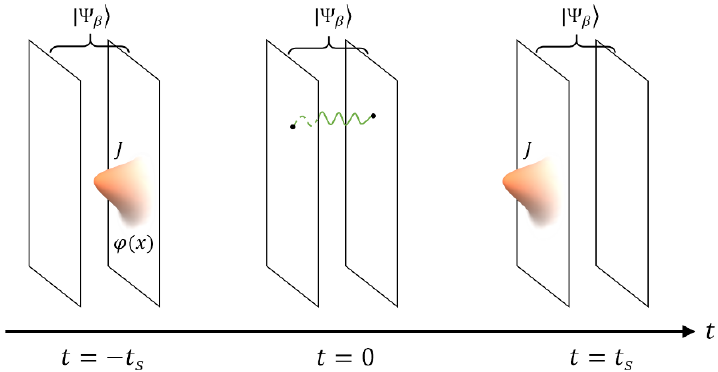
Figure 1 . The setup for the regenesis phenomenon. At t = (cid:0) t s , uncoupled systems L; R are in an entangled state (1.1). The signal in J R disappears shortly after we turn o(cid:11) the source ’ R . At t = 0, we turn on a local coupling between L and R for a short time, which we have approximated as a delta function in time in (1.2). At t = t s , the signal reappears in the L system if t s is su(cid:14)ciently large. The reappeared signal is not identical to the original signal, but related by a